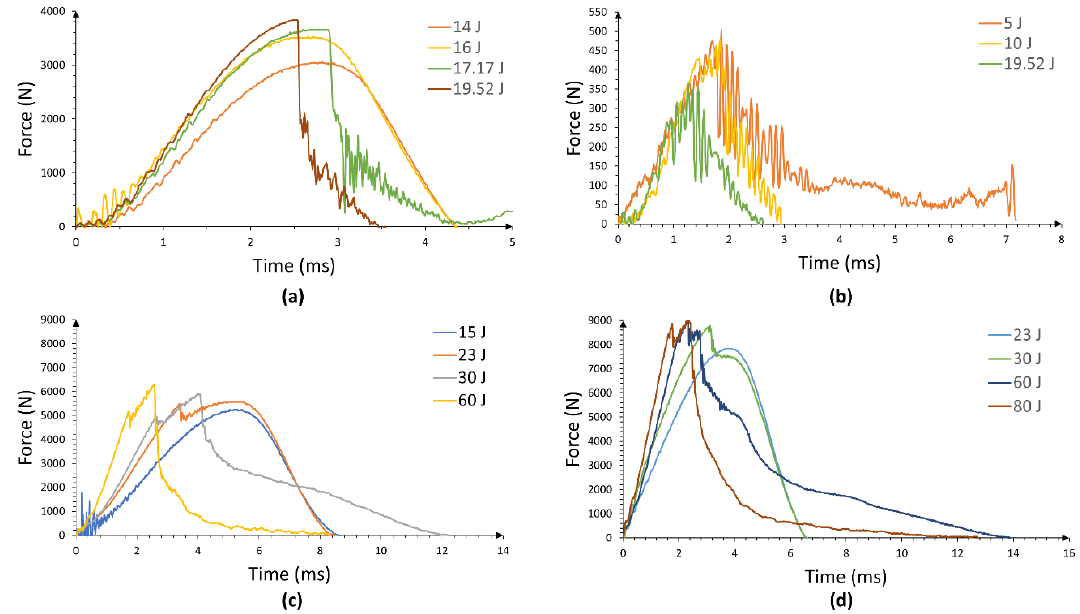
Figure 9. Force–time curves of FMLs and constituent materials for different impact energies ( a ) Plain aluminum, ( b ) Composite, ( c ) FML 2/1, and ( d ) FML 3/2.